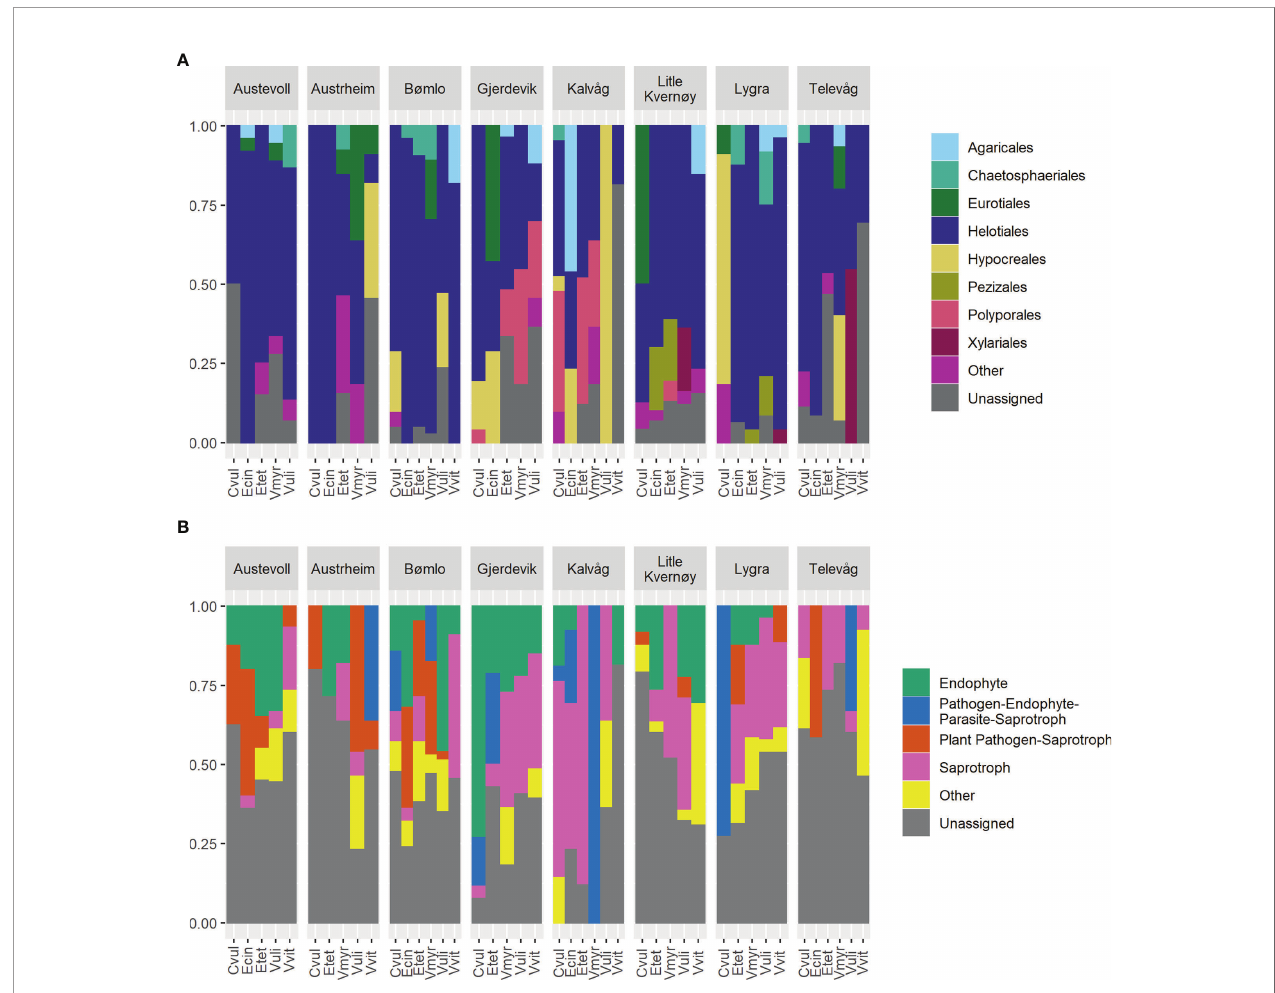
FIGURE 2 | The observed gamma diversity (total OTU richness) across the heathland sites inventoried, with estimates of total richness based on further sampling of (A) additional sites and (B) additional host plant root